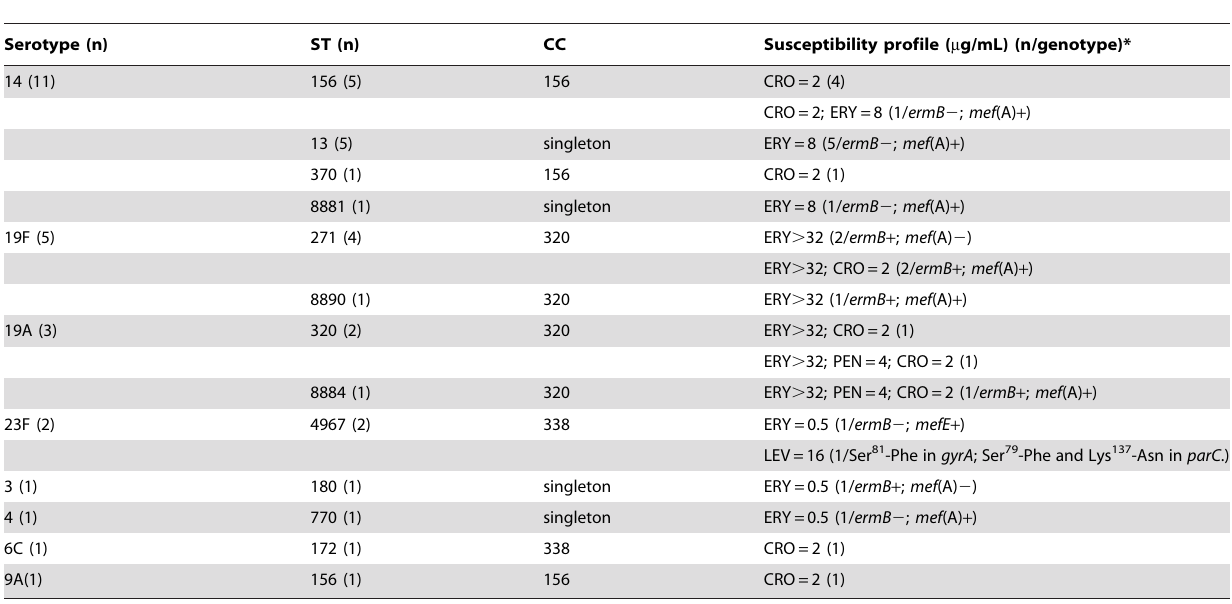
Table 6. Characteristics of pneumococci recovered from IPD showing non-susceptibility to erythromycin, levofloxacin, ceftriaxone and